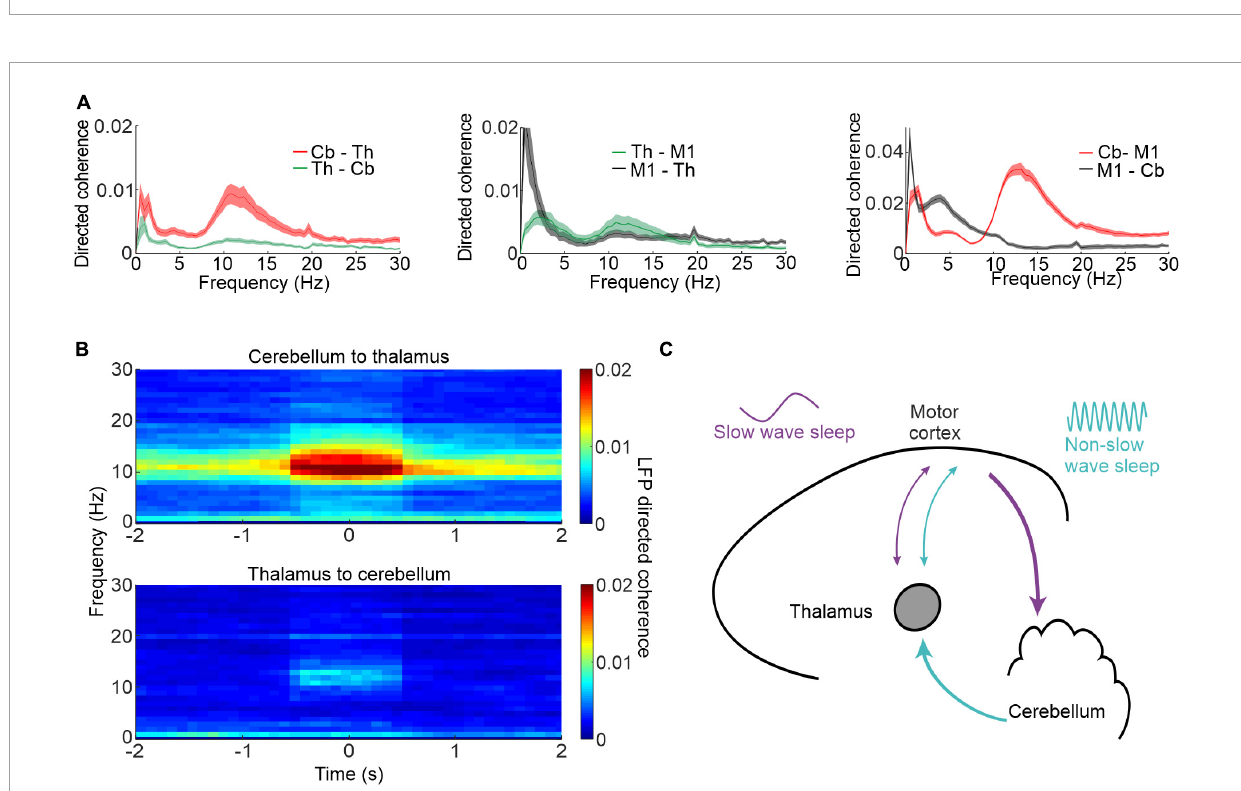
FIGURE3 Cerebellar-M1 interactions during sleep spindles. (A) Directed coherence between thalamus (Th) and cerebellum (Cb, left), thalamus and M1 (centre) and cerebellum and M1 (right). (B) Directed coherence between cerebellum and thalamus aligned by neocortical spindles. (C) Schematic showing neocortex-cerebellar interactions during different phases of sleep and at different frequencies. Figures adapted with permission from Xu et al.